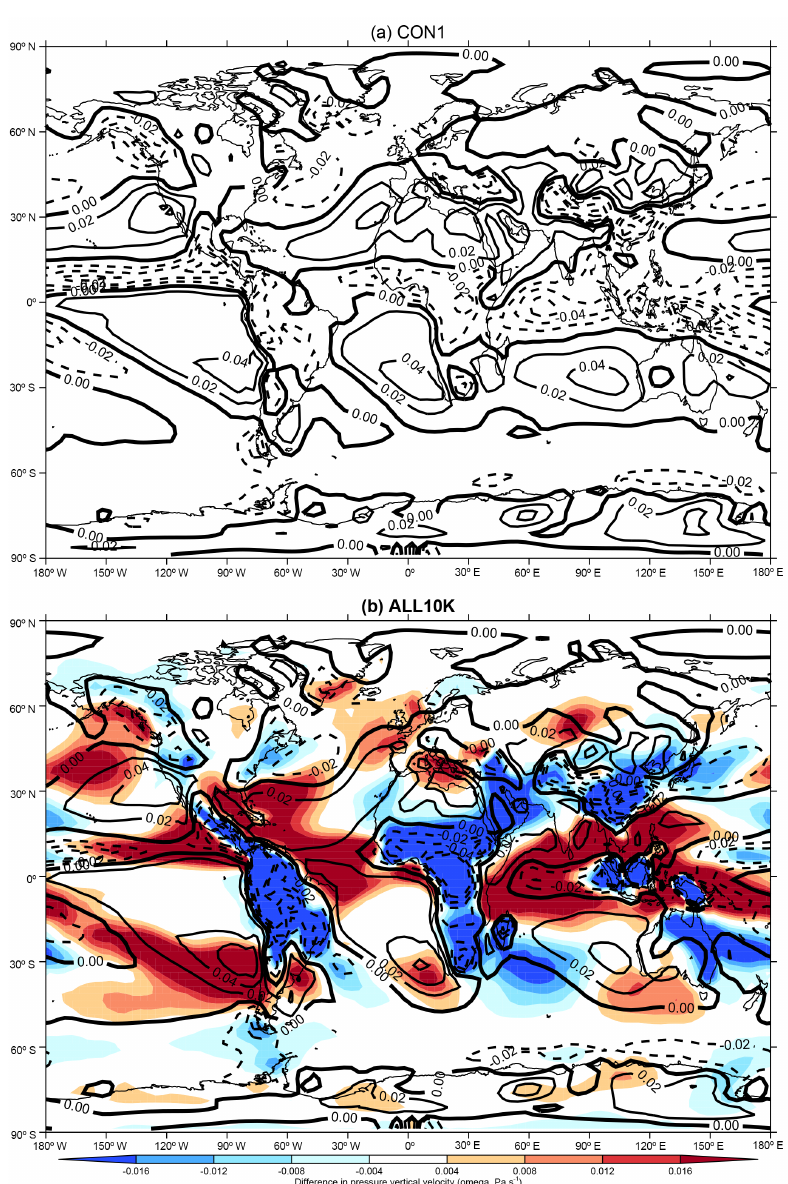
Figure 8. The climatological mean (averaged over all years of simulation) pressure vertical velocity at 500hPa ( ω 500 , Pas − 1 ) in the (a) CON1 and (b) ALL10K simulations. Solid lines indicate positive (subsidence) and dashed lines negative (uplift) values. Overlaid in (b) are the differences between ALL10K and CON1 where red shading indicates a positive difference and blue shading